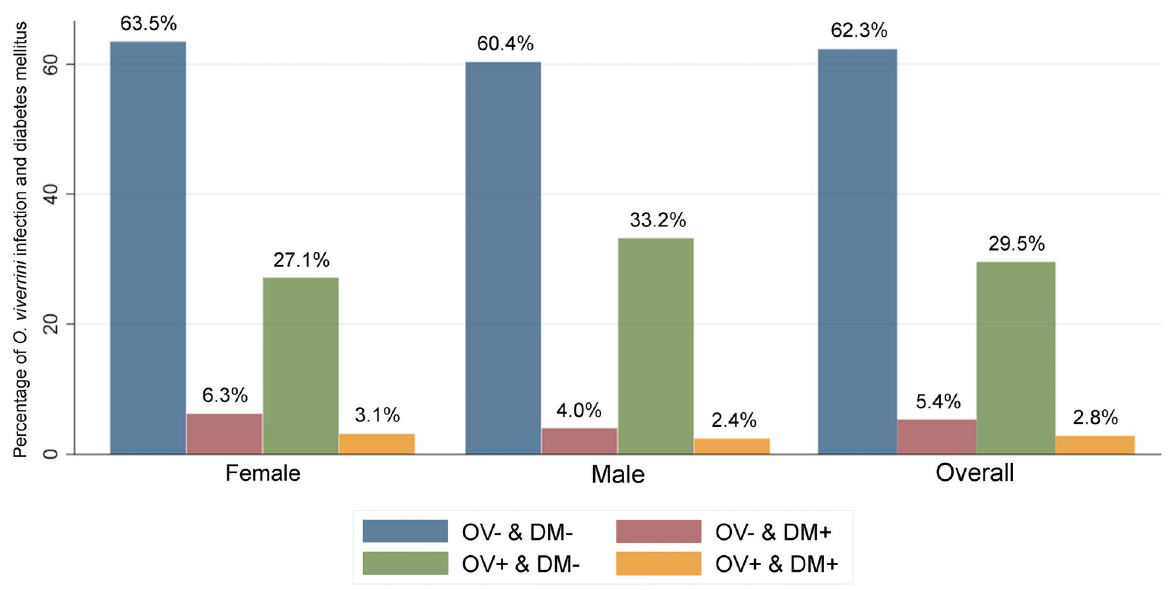
Fig 2. Breakdown of study population according to O . viverrini infection and diabetes mellitus status. Data show percentages of the study population falling into each of the four possible combinations of O . viverrini infection and diabetes mellitus status according to gender and overall.